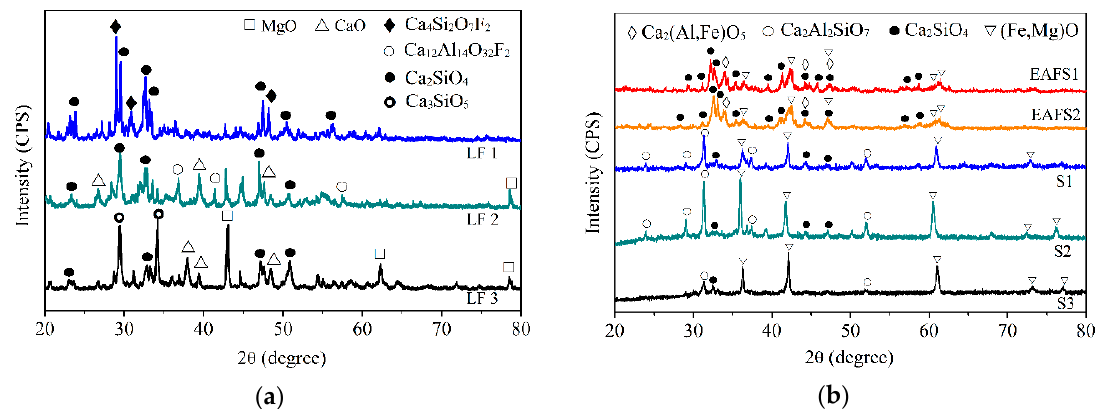
Figure 3. XRD results of ( a ) LFS; ( b ) EAFS and modified oxidizing slags.